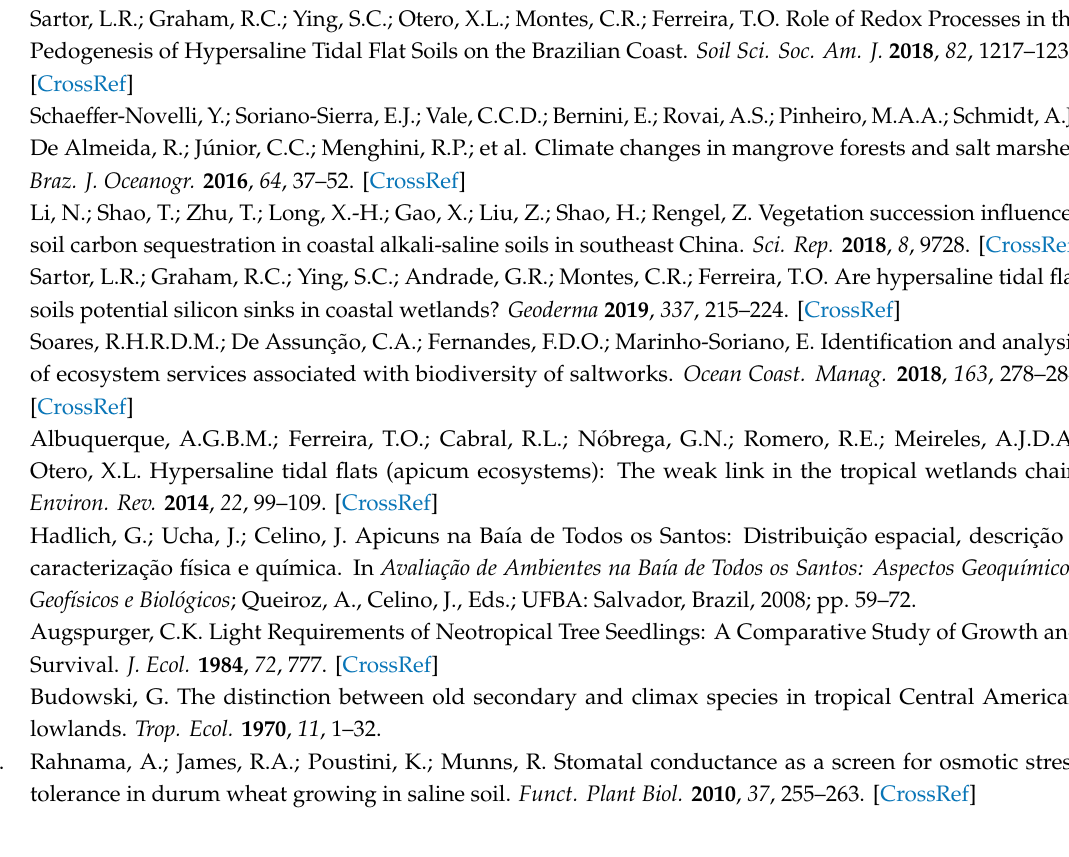
Table S1. Particle size distribution (sand, silt, and clay) in g kg − 1 for both rhizospheric (Rz) and bulk soils for the three plant species (Bm, Bp, and Sv). There is no significant statistical di ff erence (at 5% level) between Rhizospheric and Bulk soils for each species for sand, silt, and